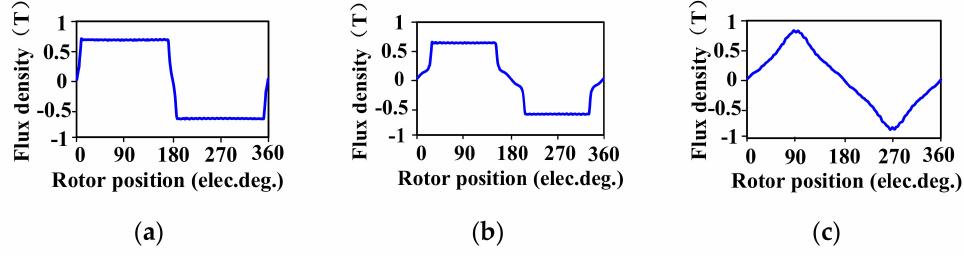
Figure 8. Open − circuit flux density. ( a ) Model 1. ( b ) Model 2. ( c ) Model